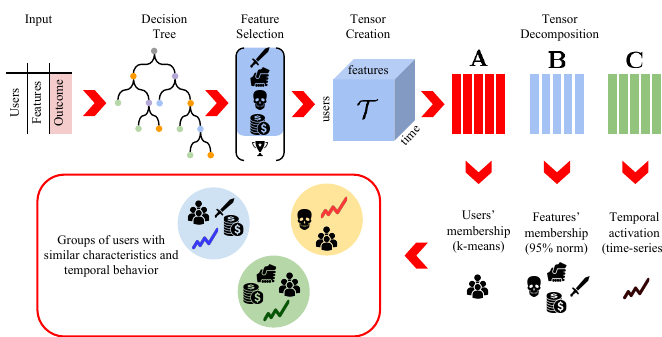
Figure 1. Framework. Our methodology is divided into several steps. First, we use Decision Trees to find the features of the dataset that are meaningful in predicting users’ performance (the outcome is the feature “winner”). Once the features are selected, we create a tensor whose dimensions coincide to users, selected features, and time. We then decompose the tensor by applying NTF and detect the factor matrices A, B, and C, providing the users’ and features membership, and temporal activity respectively. Finally, we use this information to analyze the discovered groups of users characterized by similar features and temporal